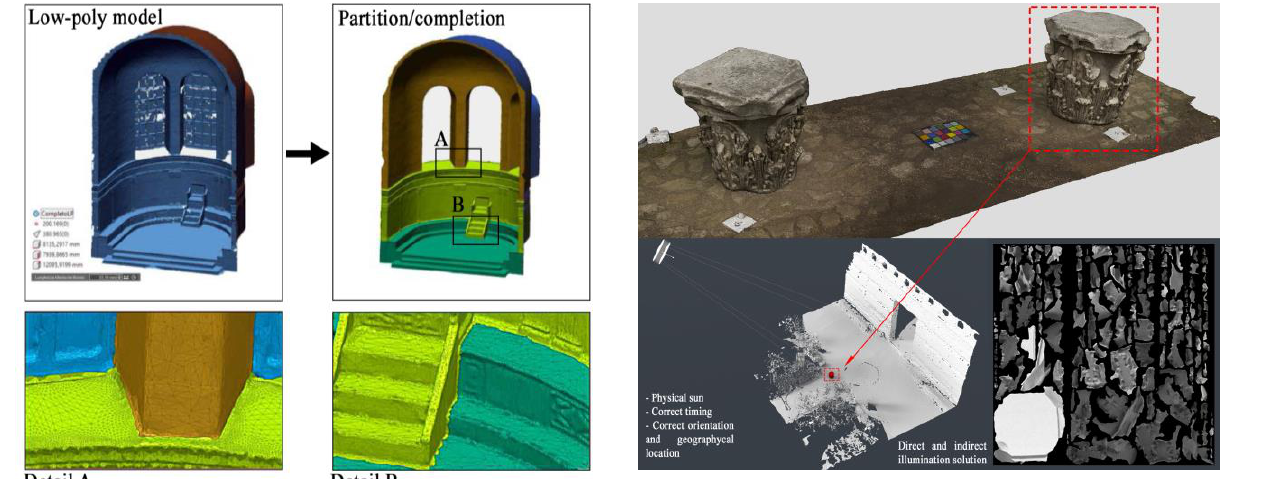
Figure 12. A capital, removed from its original position. The a Figure 11. Semantic partition on the San Vitale apse. Meshes priori knowledge of both lighting and environment geometry made of triangles do not facilitate the following of features and allows a reliable reconstruction of the lighting during the curvature lines to split the mesh. In these cases quad-dominant photogrammetric meshes are more advisable.